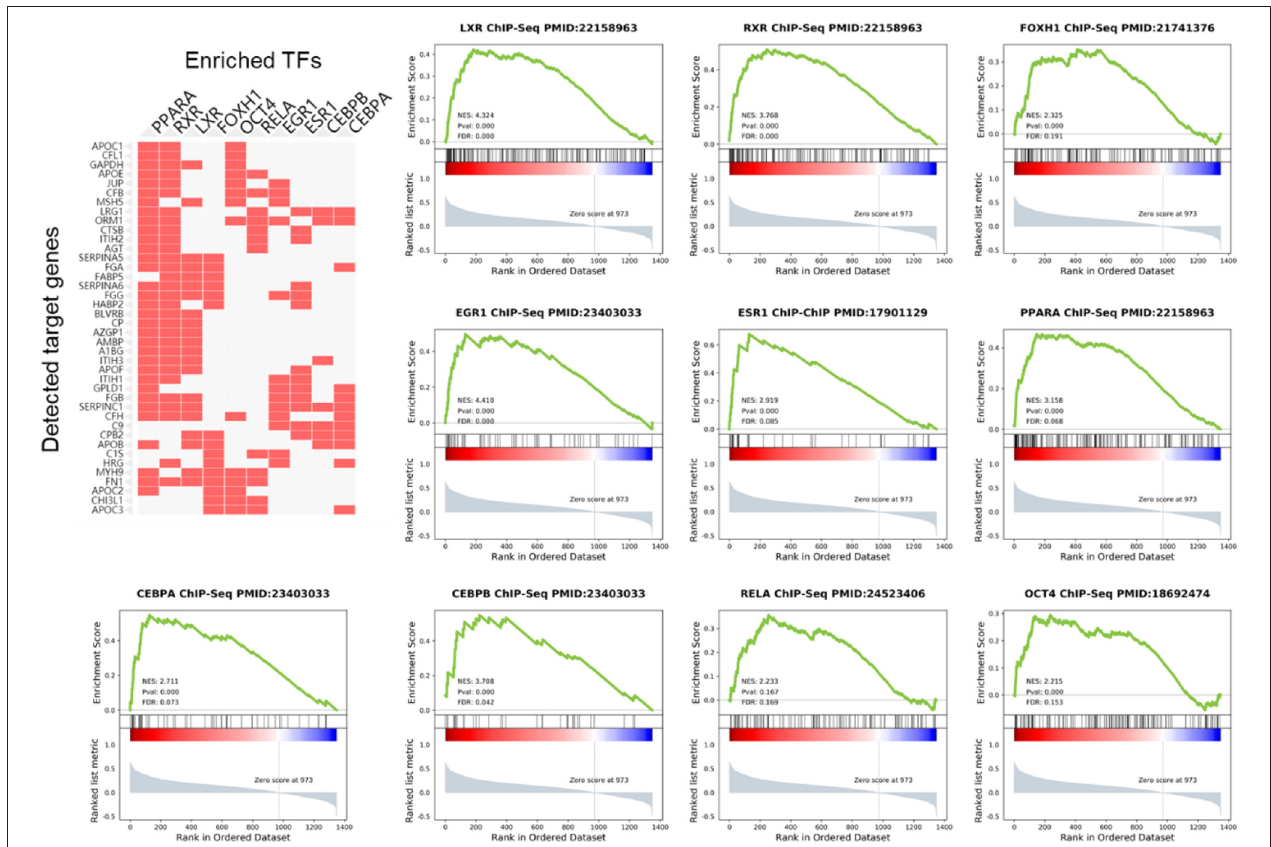
FIGURE 4 | Gene Set Enrichment Analysis (GSEA) of TFs in PDR patients. The cluster gram shows highly expressed proteins and top 10 upstream TFs inferred from ChIP-seq